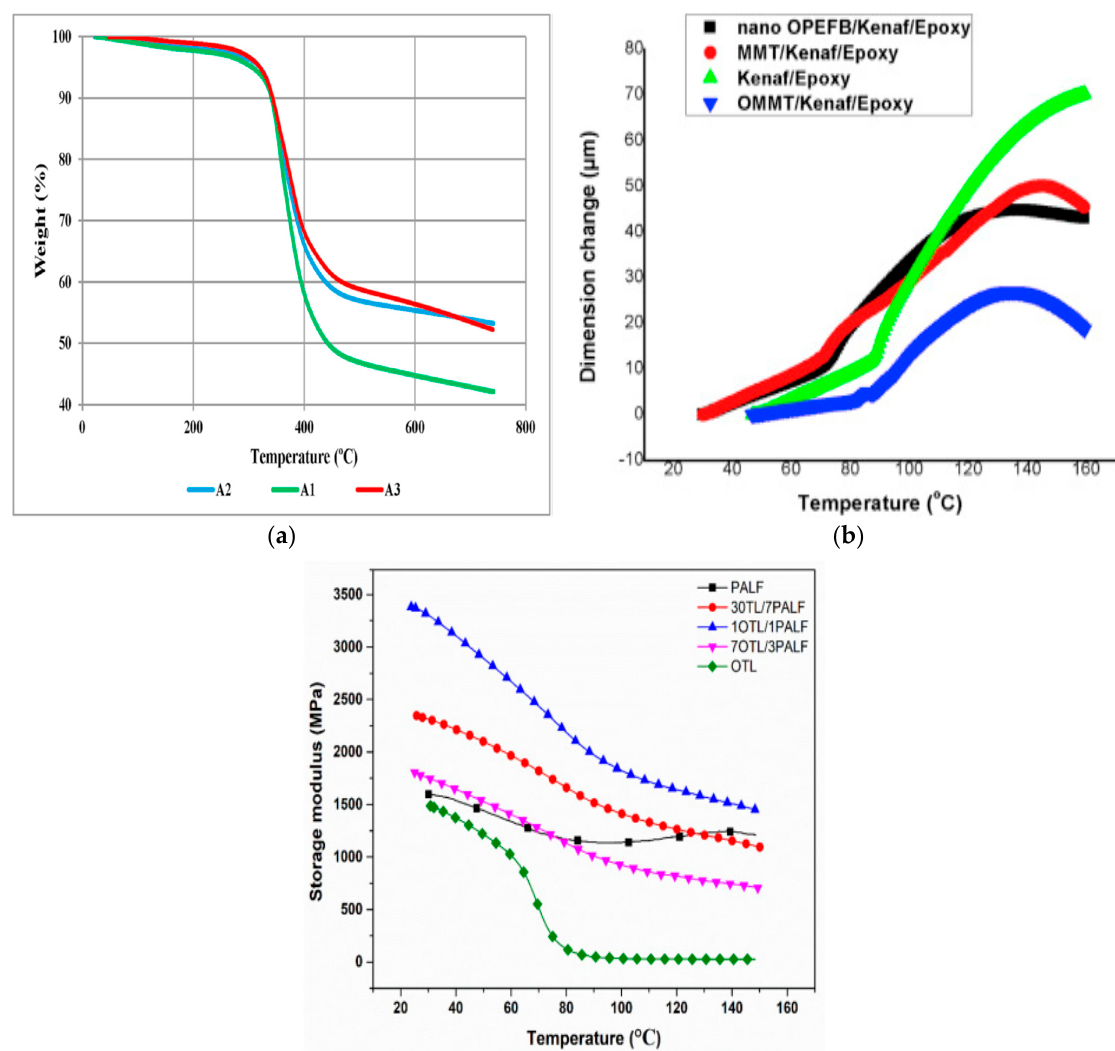
Figure 7. ( a ) TGA analysis thermogram for epoxy-CF modified coir-fiber at 30% (A1), 20% (A2), and 10% (A3), ( b ) TMA graph of kenaf/epoxy composites and filler-filled kenaf/epoxy hybrid nanocomposites, and ( c ) DMA graph of olive tree leaves/pineapple leaf hybrid epoxy composites [152,154] (Reprinted/adapted with permission from Elsevier ref.5457220515829 Copyright 2022).